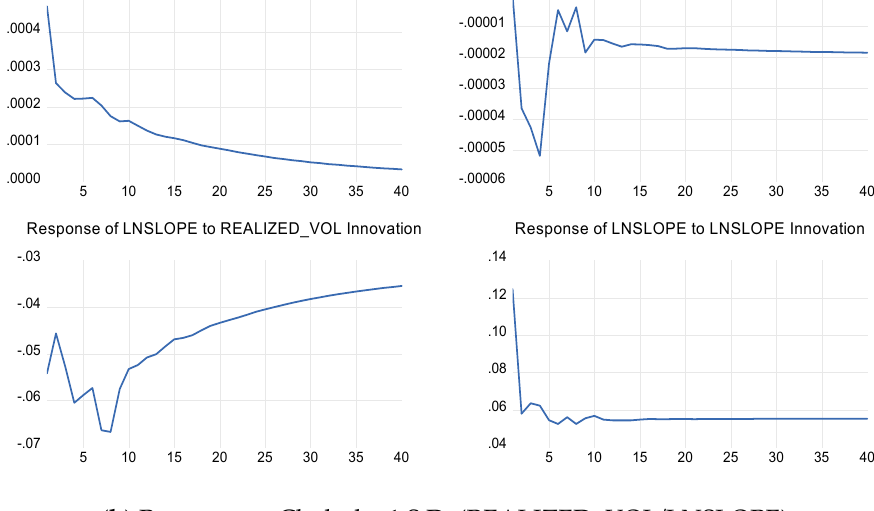
Figure 4. Impulse responses of VECM ( a ) Response to Cholesky 1 S.D. innovations of REAL- IZED_VOL to HFT innovations in upper-right panel; ( b ) Response to Cholesky 1 S.D. innovations of REALIZED_VOL to the natural logarithm of slope innovations and vice versa in upper-right and lower-left panels.